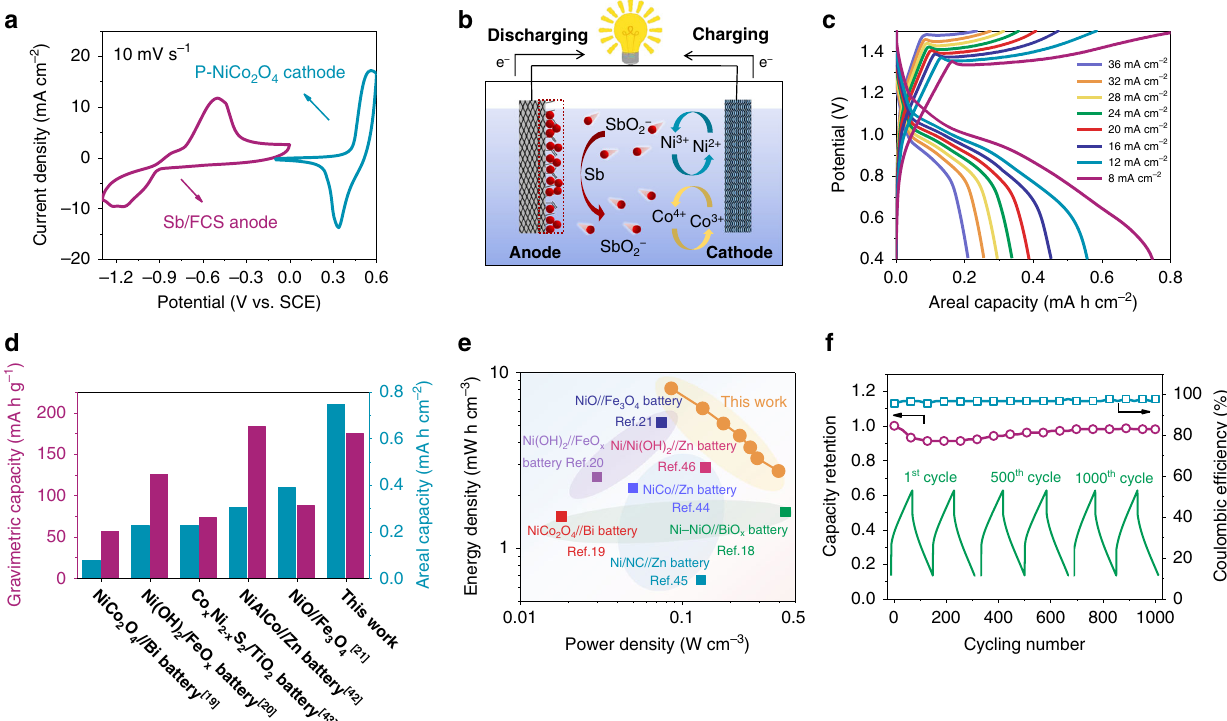
Fig. 4 Electrochemical performance of assembled AAB using Sb/FCS anode. a CV curves of the P-NiCo 2 O 4 cathode and Sb/FCS anode measured at 10 mV s − 1 . b The energy storage mechanism of the NiCo//Sb battery. c Galvanostatic charge – discharge (GCD) curves at different current densities, d areal capacity and gravimetric capacity comparison with previous studies 19 – 21,42,43 , e Ragone plots, the values reported for other energy storage devices are added for comparison 18 – 21,44 – 46 and f the cycling stability of the NiCo//Sb